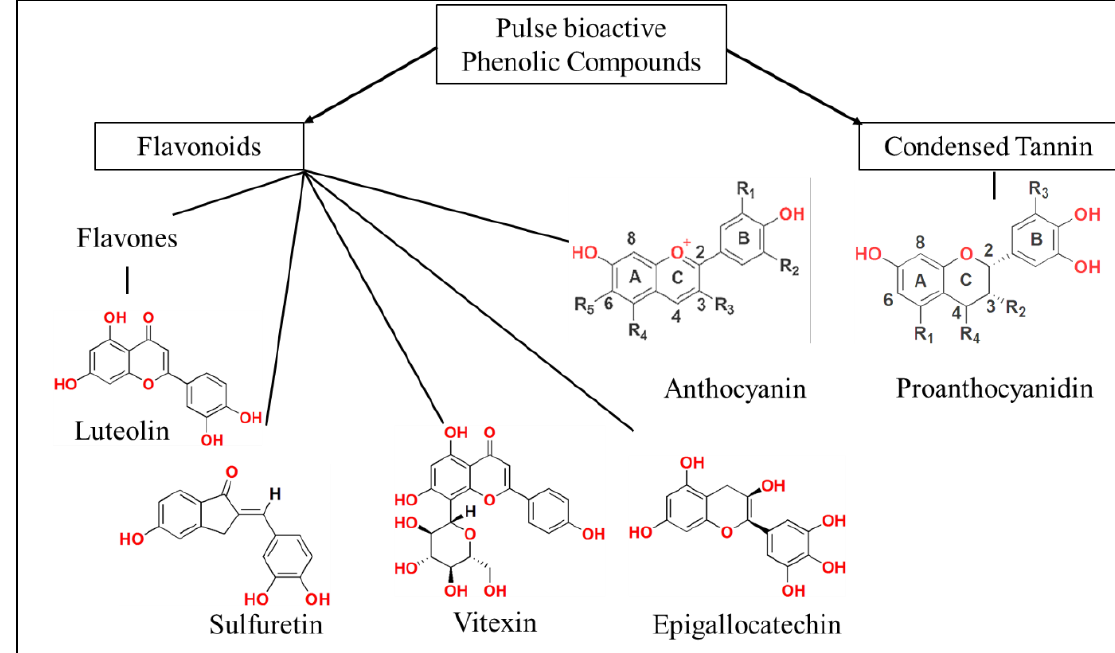
Figure 1. Bioactive flavonoids, anthocyanins, and tannins found in pulses.